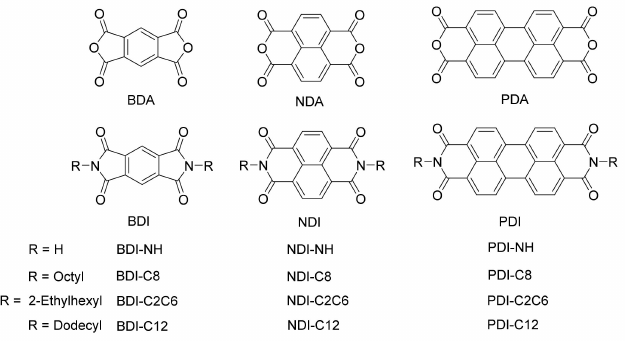
Figure 1. Chemical structures of the aromatic diimide-based compounds studied in this